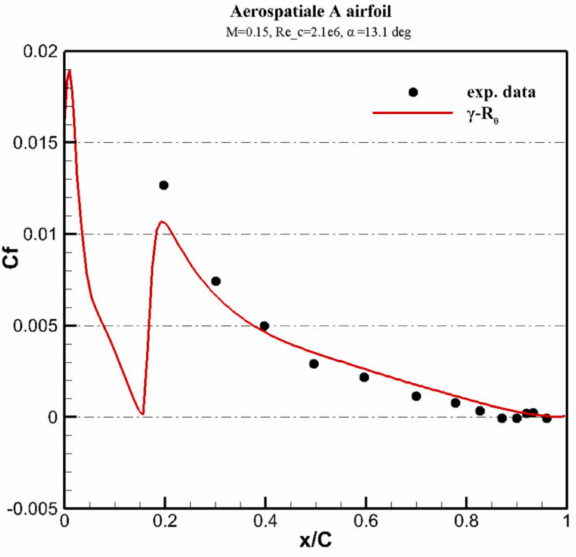
Figure 6. Skin friction coefficient distribution for the original formulation over Aerospatiale A-airfoil.